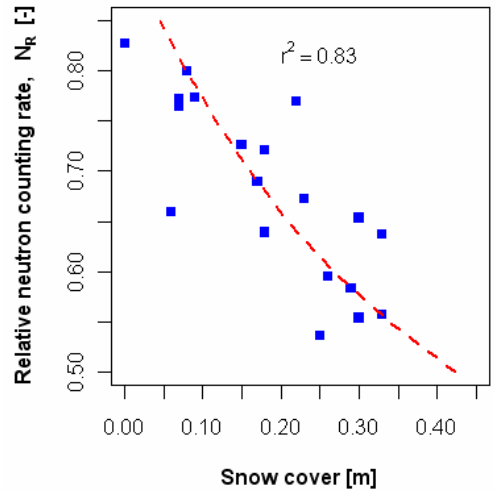
Fig. 9. Normalized daily neutron counting rate ( N R ) versus daily Figure 9. Normalized daily neutron counting rate ( N R ) versus daily snow cover in PIK 2 snow cover in PIK weather station (Telegrafenberg-Potsdam, Ger- weather station (Telegrafenberg-Potsdam, Germany). 3